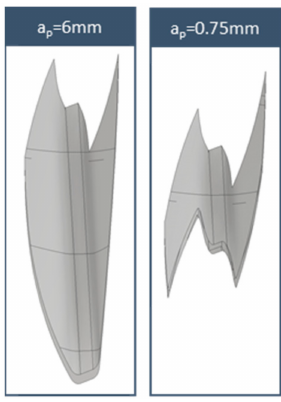
Figure 12. Solid chip geometries for strategy